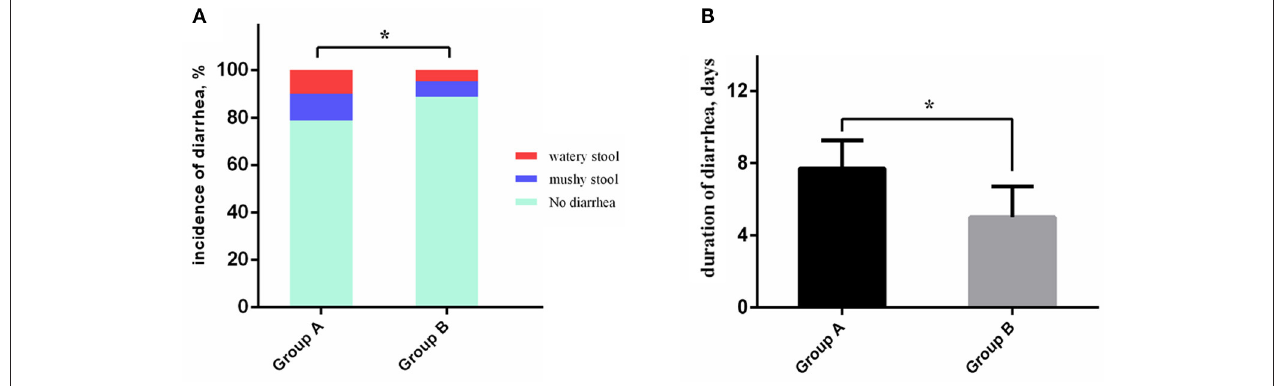
FIGURE 3 | Antibiotic-associated diarrhea characteristics comparison between the two groups. (A) The severe diarrhea patients and overall diarrhea patients occupy a bigger proportion in Group A than in Group B. (B) The duration of diarrhea of patients in Group B was significantly shorter than in Group A. * P < 0.05.